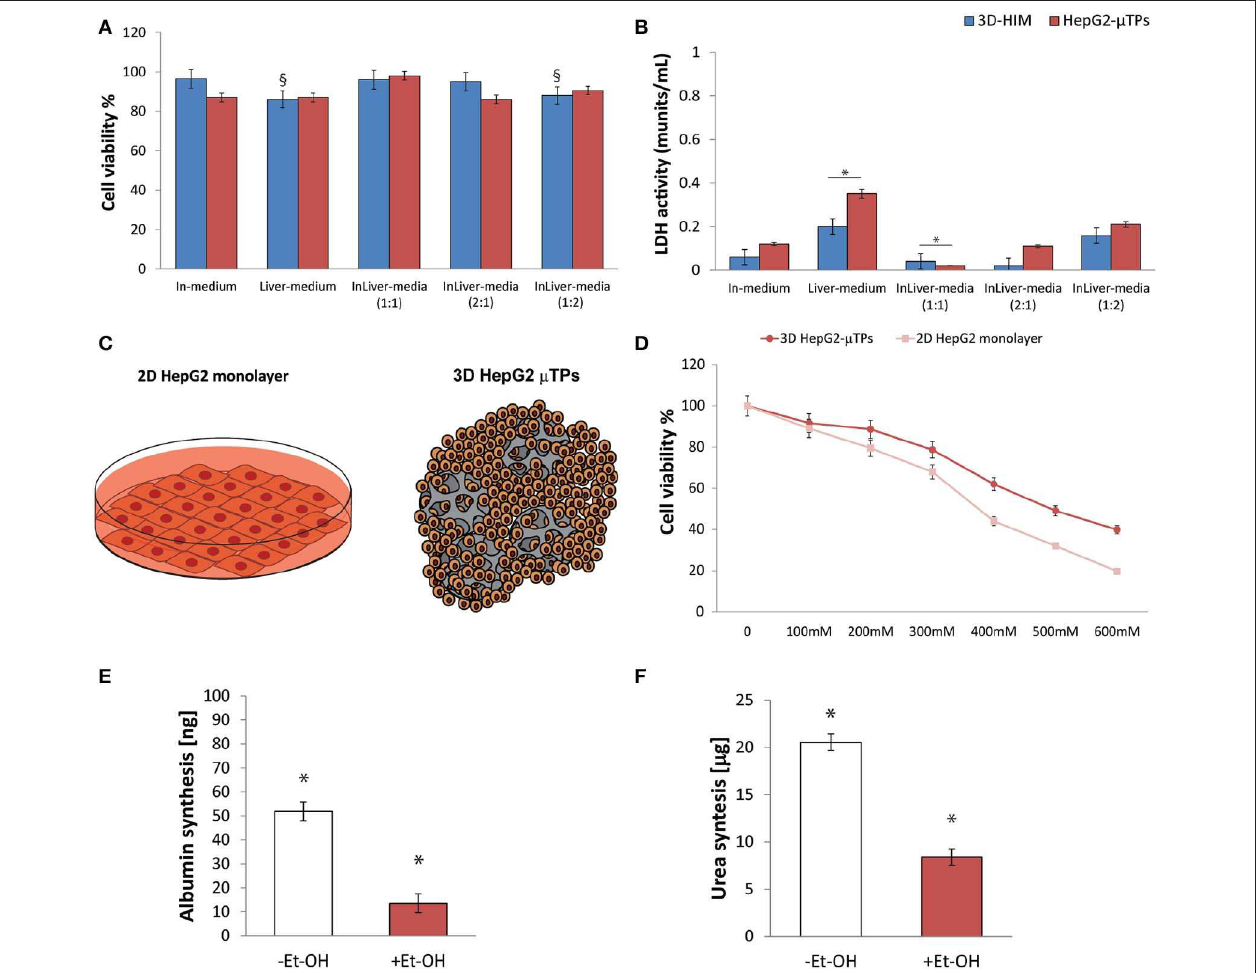
FIGURE 3 | Selection of optimal media combination in InLiver-OC, HepG-2 cytotoxicity under different Et-OH concentrations and 3D HepG2- µ TPs metabolic activity under 400mM Et-OH. MTT cell viability (A) and LDH (B) assays on 3D-HIM and HepG2- µ TPs cultured with different media combinations ( § p < 0.05; * p < 0.05); schematic representation of standard culture dishes (2D HepG2 monolayer) and 3D configuration (3D HepG2- µ TPs) (C) ; dose response on 2D HepG2 monolayer vs. 3D HepG2- µ TPs at different Et-OH concentrations (0–600mM) (D) ; comparison of Albumin (E) and urea production (F) on untreated (–Et-OH) and 400mM Et-OH-treated ( + Et-OH) 3D HepG2- µ TPs. The Albumin amount is expressed in “ng” and the urea synthesis is indicated in “ µ g.” All the experiments were performed in triplicate ( n = 3), Values represent the mean and the standard deviation (* p <